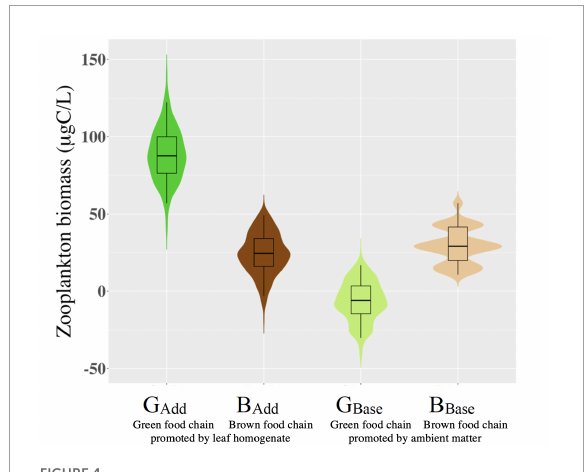
FIGURE4 Contribution to zooplankton biomass by ambient organic matter and nutrients through the green chain (G Base ) and the brown food chain (B Base ) and those by leaf homogenate through green food chain (G Add ) and brown food chain (B Add ). Filled areas indicate the frequency of distributions of bootstrap data, boxplots represent the median and the first and third quantiles, and vertical bars are ± 95% CI on the mean.